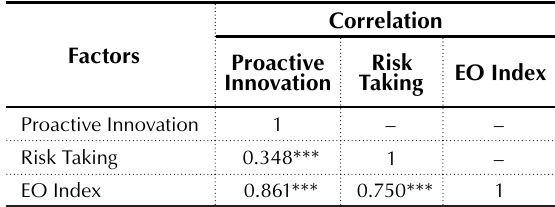
Table 2. Correlation matrix for EO dimension construct and EO